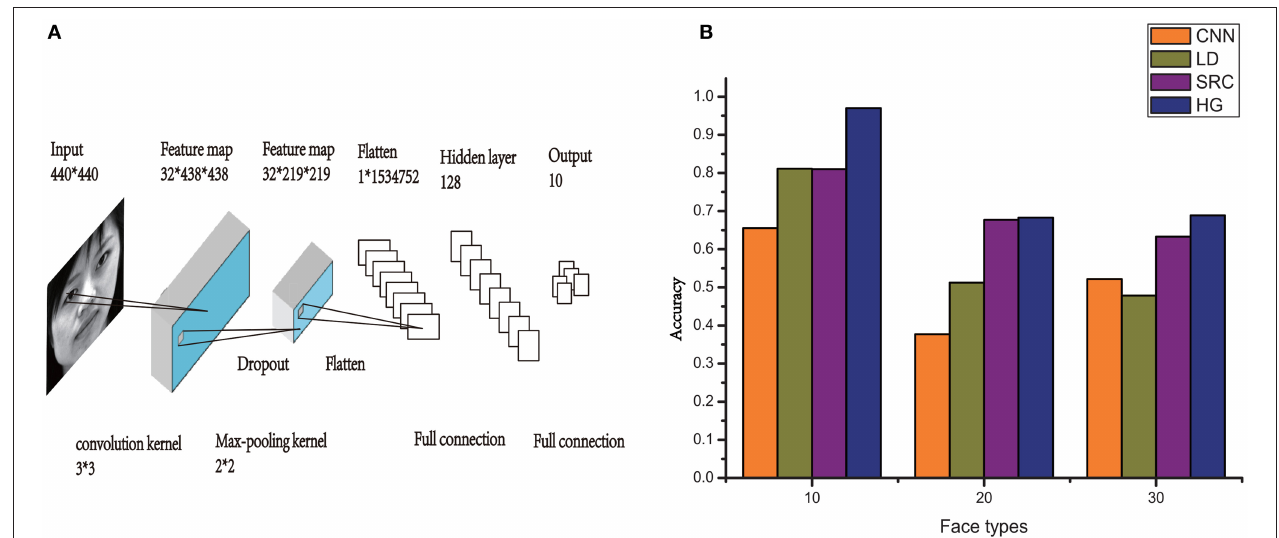
FIGURE 8 | (A) An illustration of the architecture of CNN. (B) Comparison of HG (our method) with the other models on the performance of CASIA-3D face V1 database with different number of individual types.